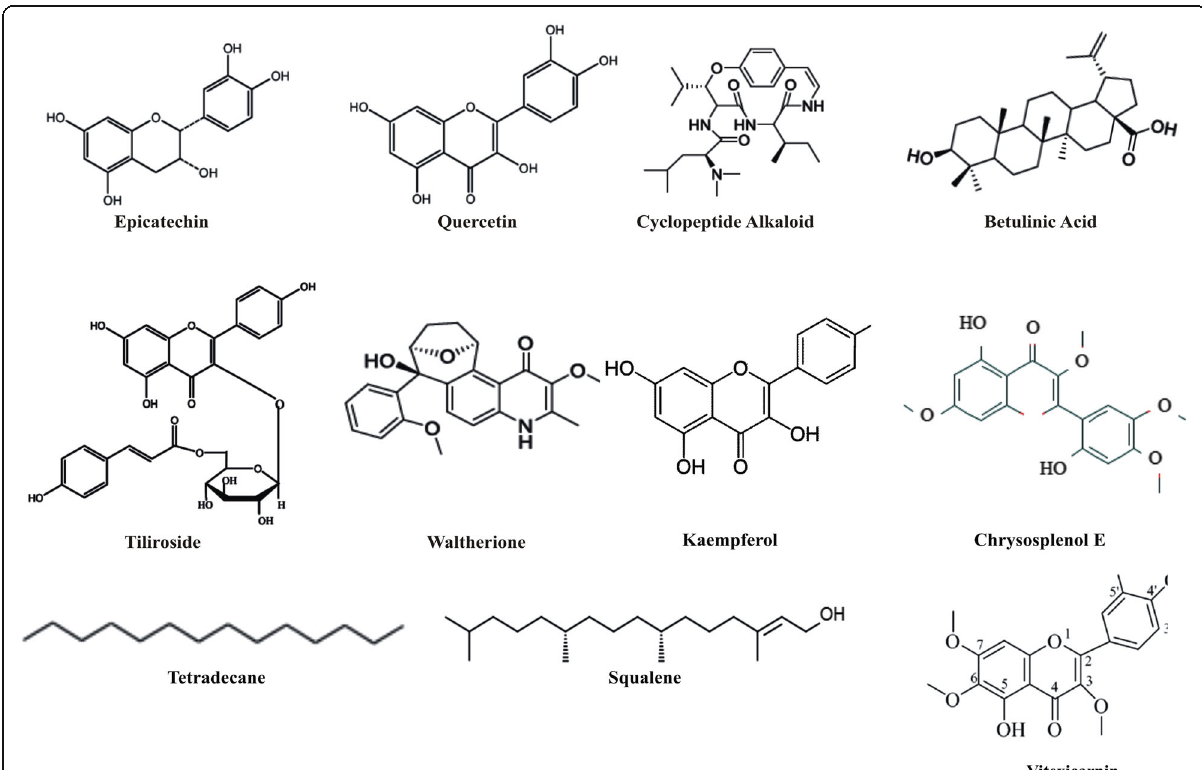
Fig. 2 Major bioactive compounds isolated from W.